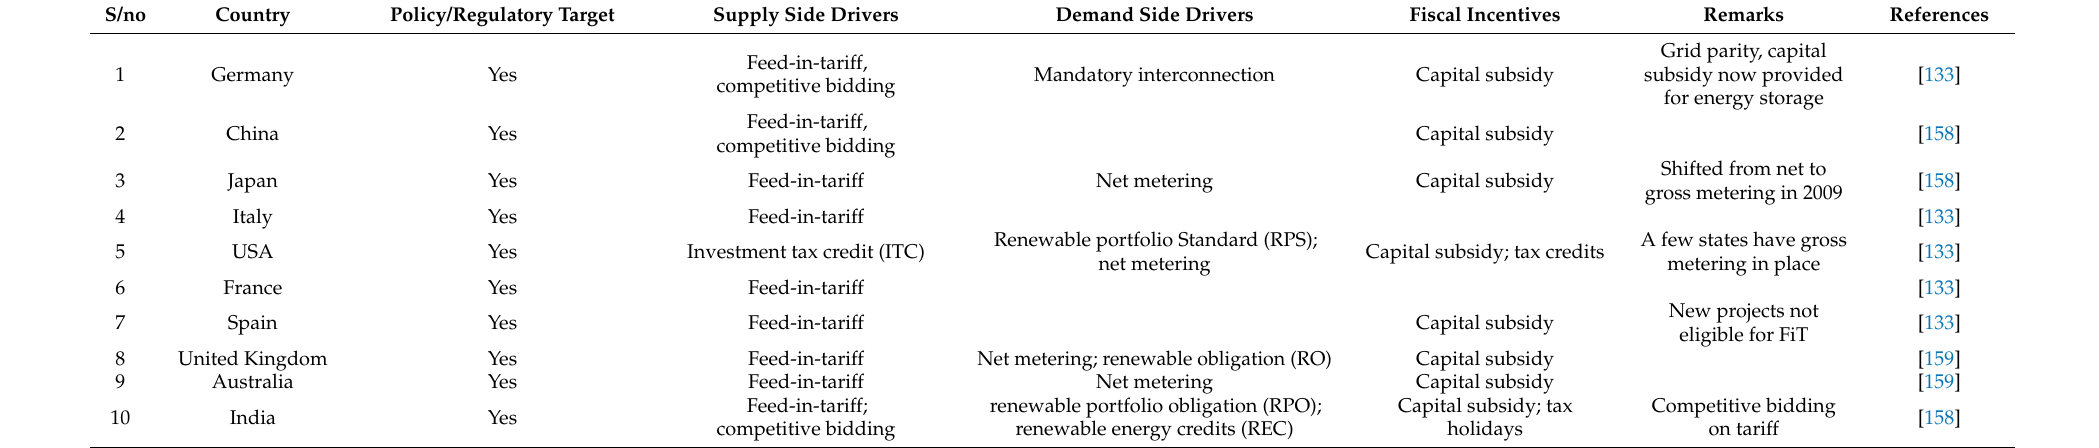
Table 4. Key drivers for growth in major solar PV